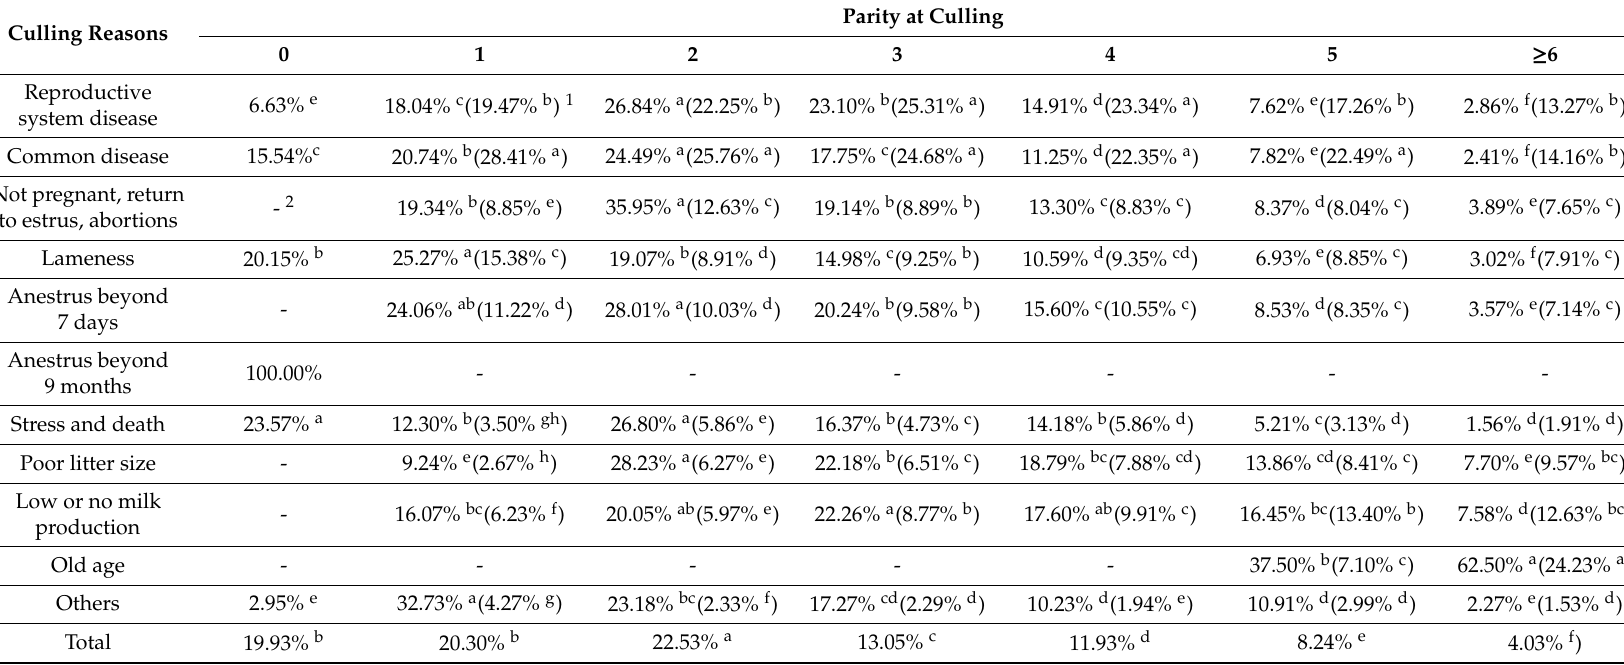
Table 2. Parity distribution of di ff erent reasons and reasons distribution of di ff erent parities for gilt and sow